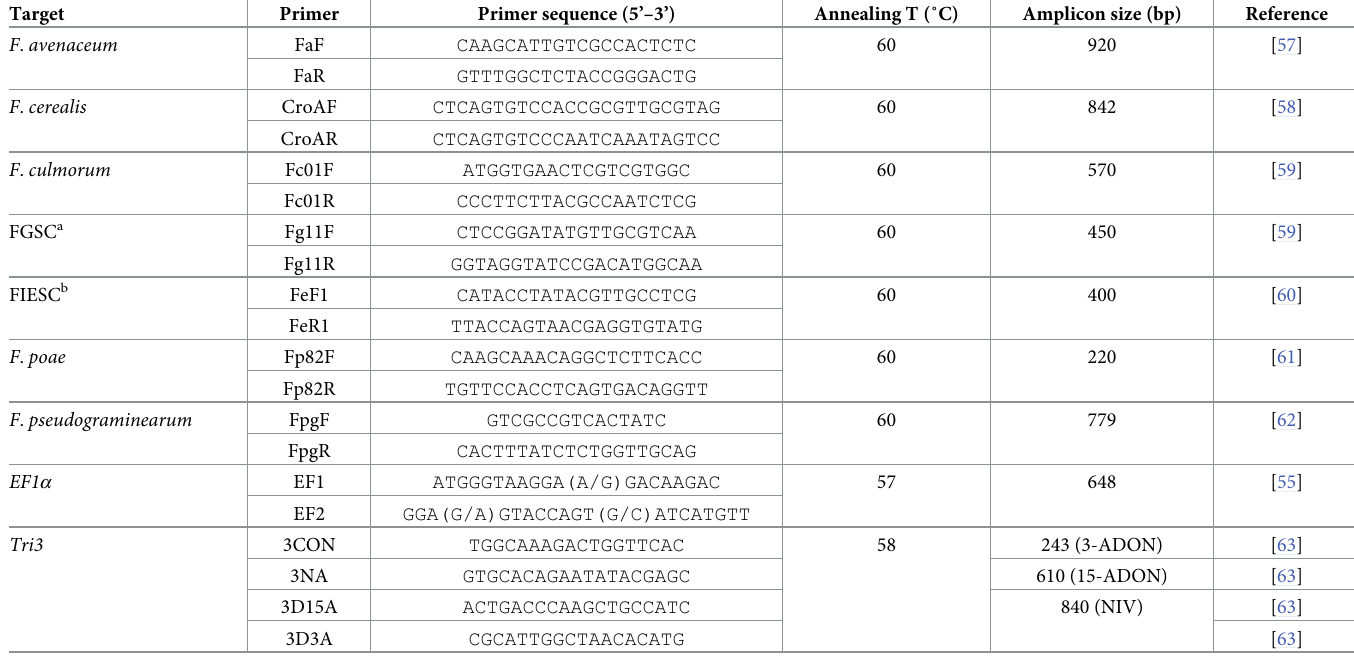
Table 2. Primer names, sequences and expected sizes of PCR products of Fusarium species associated with head blight of wheat. Target